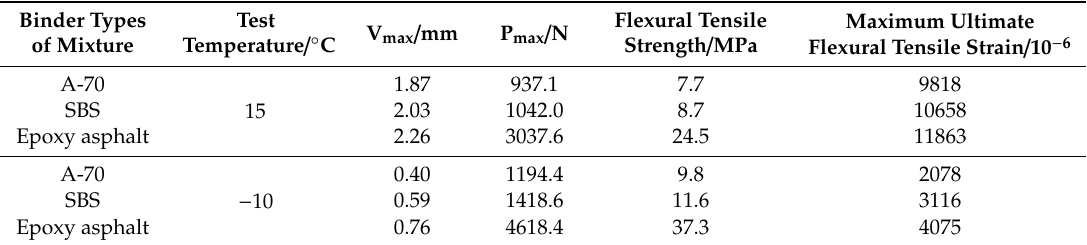
Table 9. Three-point bending test results for the three types of aggregate asphalt mixtures.